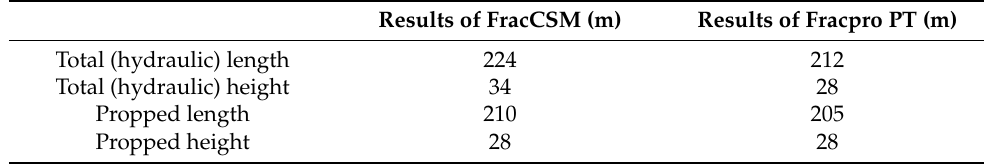
Figure 9. Comparison of the fracture geometry and proppant concentration distribution predicted by FracCSM and Fracpro PT. Upper: fracture plane simulated by FracCSM. Lower: fracture plane simulated by Fracpro PT. Table 3. Comparison of the fracture geometry factor between FracCSM and Fracpro